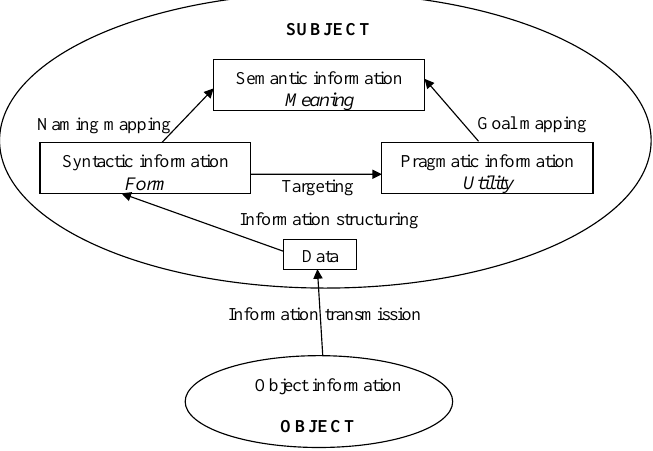
Figure 6. Conversion of object information into perceived information in intelligent systems.